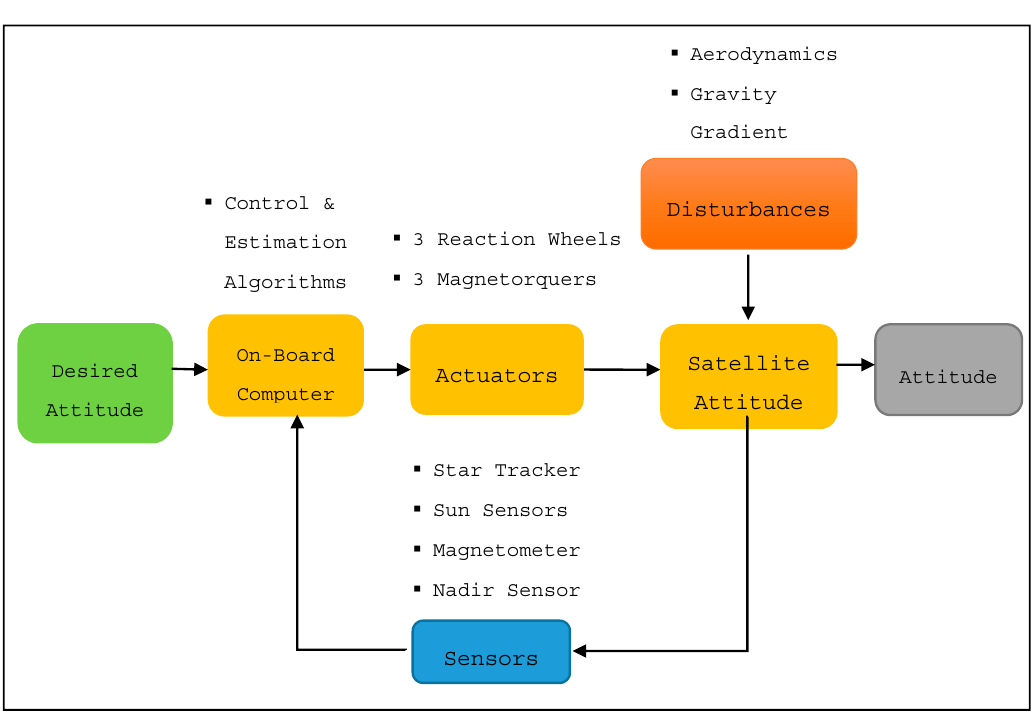
Figure 7. MeznSat Attitude Determination and Control Subsystem (ADCS) architecture.